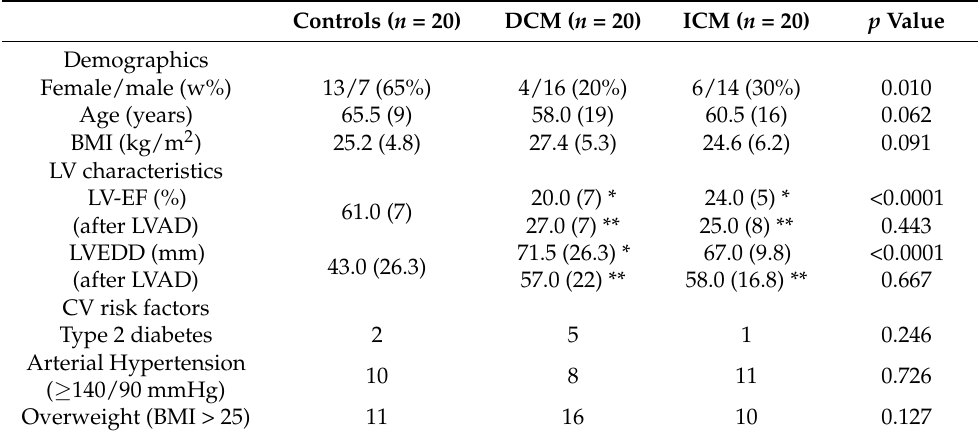
Table 1. Clinical and demographic data of the